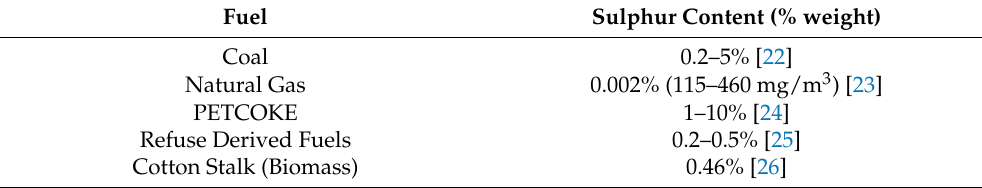
Table A5. Sulphur content in various fuels typically used in fuel burning